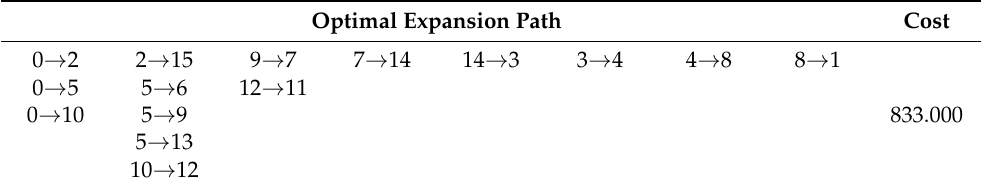
Table 3. Expansion process and costs of firm X ( u = 0.5).